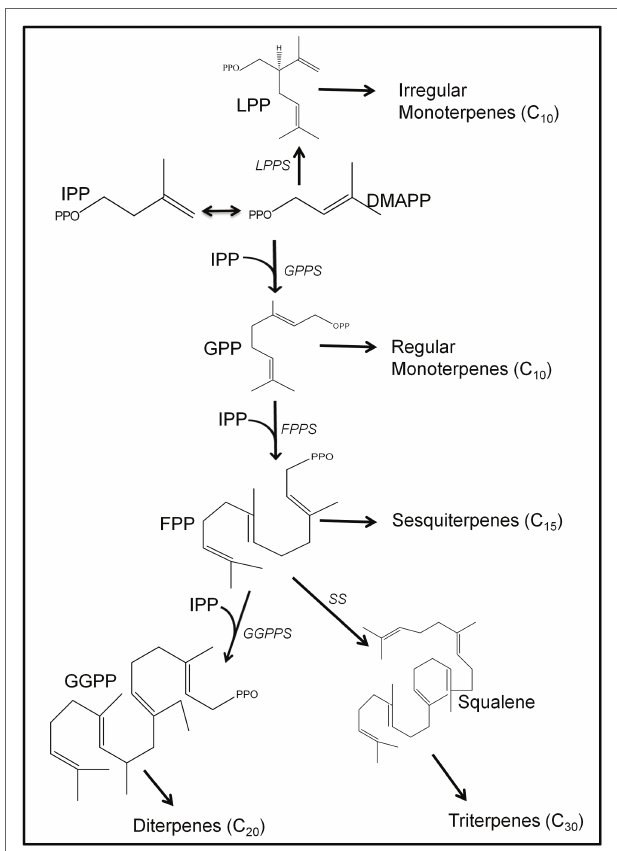
FIGURE 1 | Overview of the biosynthetic pathways for major plant isoprenoids. The biosynthesis of isoprenoids starts with a common pool of isopentenyl diphosphate (IPP) and dimethylallyl diphosphate (DMAPP). IPP and DAMPP are initially condensed to form either lavandulyl diphosphate (LPP), the precursor for irregular monoterpenes, or geranyl diphosphate (GPP), the precursor to regular monoterpenes. GPP can also be condensed with one or two IPP units to form FPP for sesquiterpene synthesis, or geranylgeranyl diphosphate (GGPP) for diterpene production. Two FPP units can be condensed to form squalene, the immediate precursor for triterpene metabolism. The isoprenyl diphosphate synthases (IDSs) that catalyzed the precursor(s) into specific prenyl diphosphate include LPP synthase (LPPS), GPP synthase (GPPS), geranylgeranyl diphosphate synthase (GGPPS), FPP synthase (FPPS), and squalene synthase